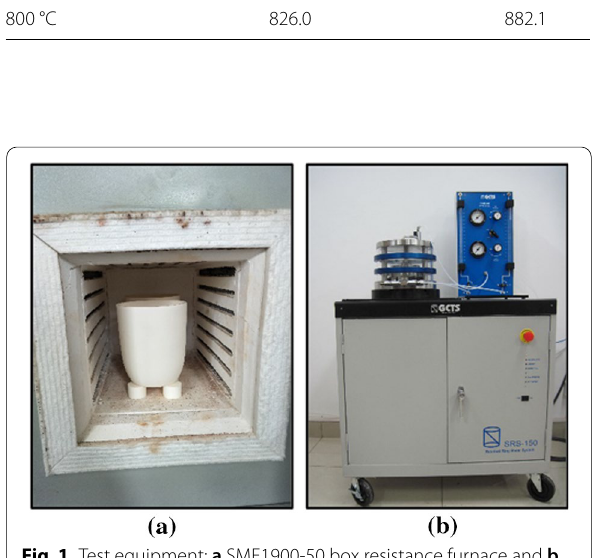
Fig. 1 Test equipment: a SMF1900-50 box resistance furnace and b GCTS SRS-150 ring-shear apparatus